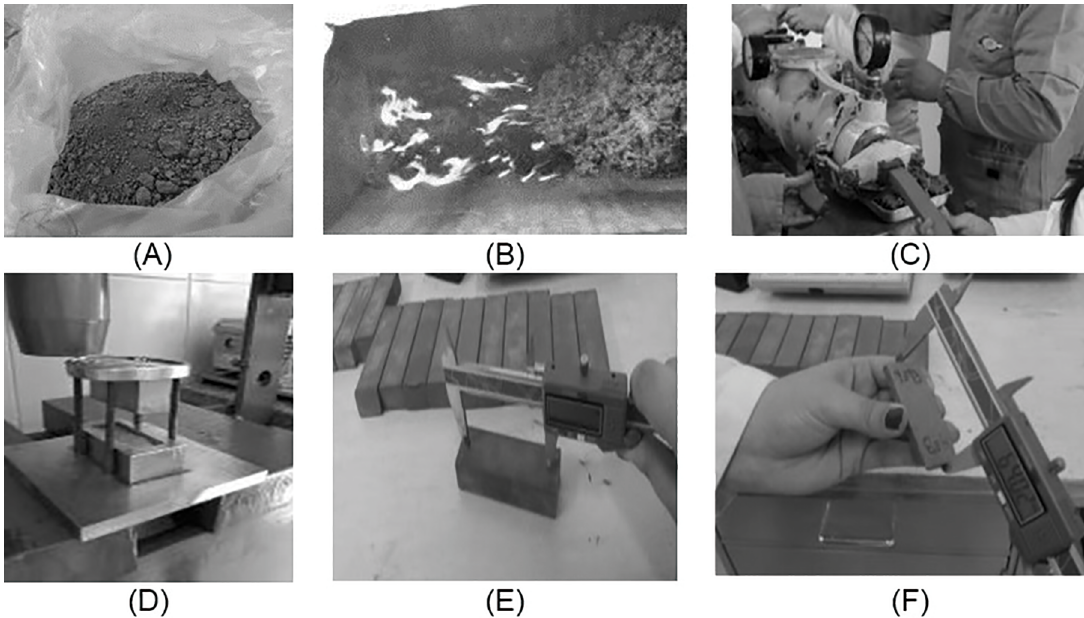
Figure 1. Clay pre-treatment (A), residue burning (B), vacuum extruder (C), steel mold used in pressing (D), metering of extruded (E) and pressed samples (F). In addition, the clay that was shaped by pressing was sieved through a 100-mesh sieve (Solotest,Brazil).